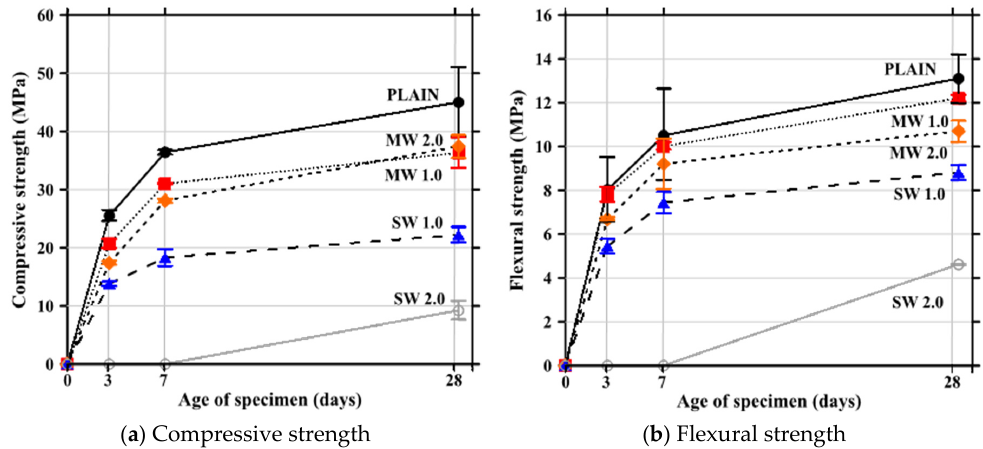
Figure 10. Strength of carbon nanotube (CNT) cementitious composites: ( a ) compressive strength and ( b ) flexural strength.